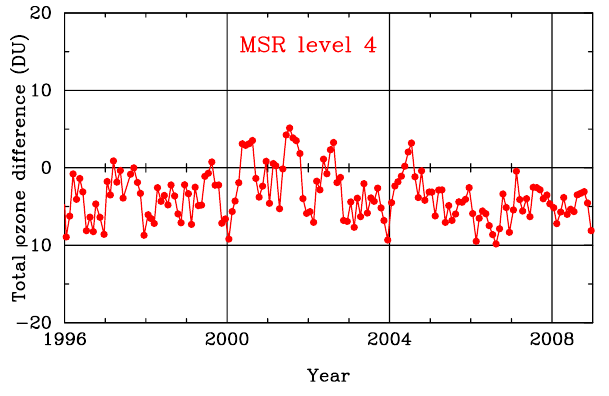
Fig. 5. Monthly averaged anomalies (satellite measurement mi- nus ground measurement) for the overpass data of the MSR at the ground station De Bilt (5.18 ◦ E, 52.1 ◦ N) in the Netherlands.